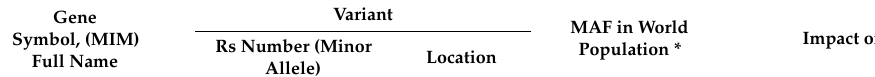
Table 3. Genetic background for vitamin C deficiency in the human